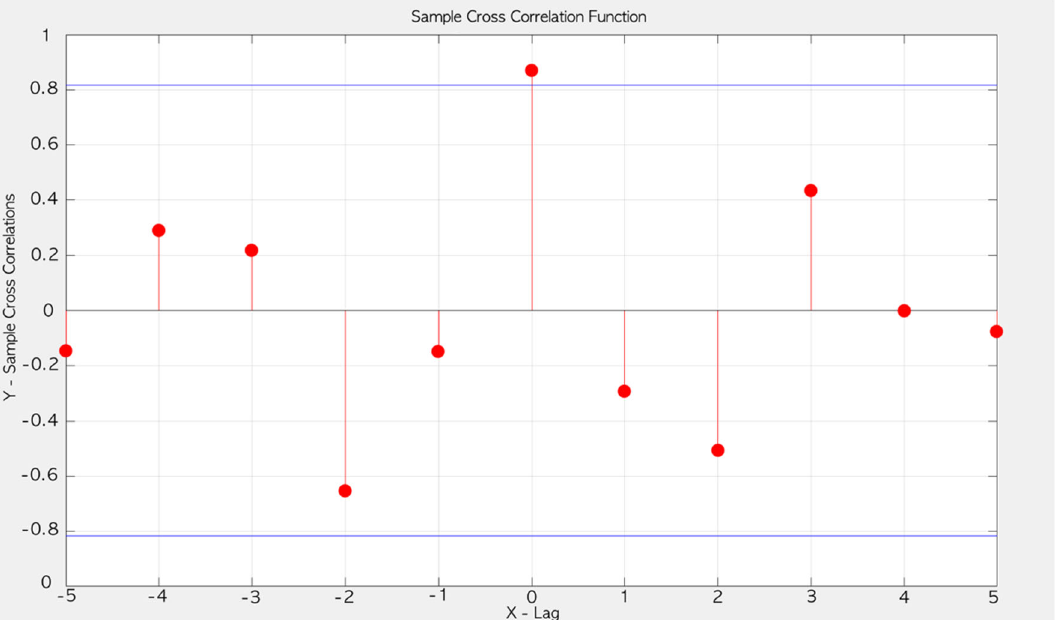
Figure 5. Cross ‐ correlations between MFMS and time ‐ shifted values of BMP . Horizontal blue lines Figure 5. Cross-correlations between MFMS and time-shifted values of BMP. Horizontal blue lines display the upper and lower confidence bounds. The X ‐ axis shows time ‐ shifted values of sense of display the upper and lower confidence bounds. The X -axis shows time-shifted values of sense of presence on the effect of CS. Y ‐ axis indicates sample cross ‐ correlation values. presence on the effect of CS. Y -axis indicates sample cross-correlation